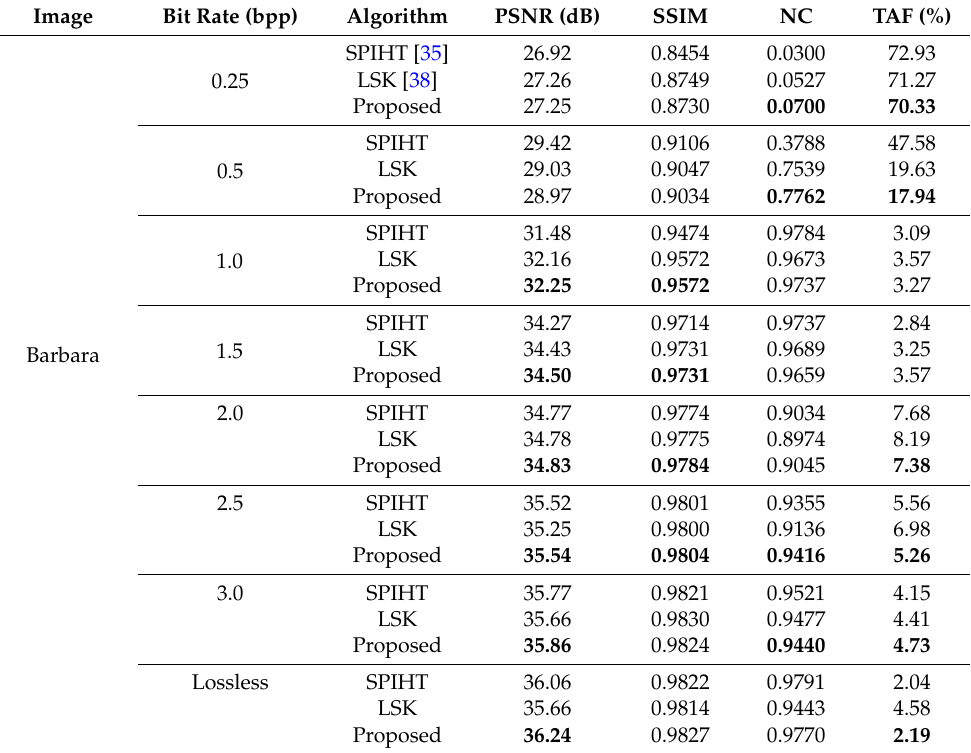
Table 2. PSNR, SSIM, TAF and NC performance on the Barbara Image.